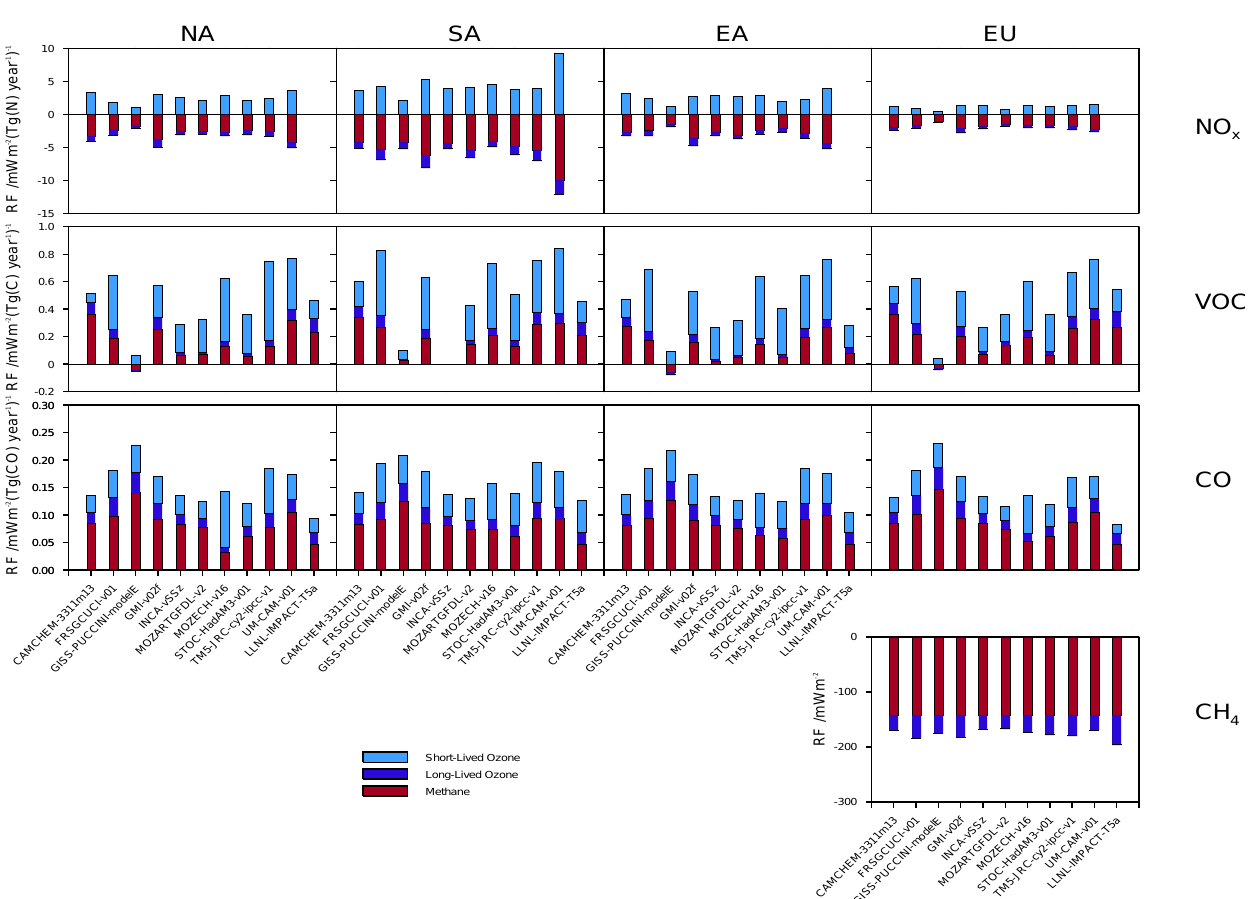
Figure 3. Radiative forcing, normalised by emissions mass change, for NO x (first row), VOCs (second row), CO (third row), and CH 4 (bottom), for each of the 11 models, for each of the four regions given in Table 1. Units are mWm − 2 ( Tgyear − 1 ) − 1 for the NO x , VOCs and CO cases. For the CH 4 case, results are presented un-normalised, in mWm − 2 . Colours show RF due to short-lived ozone (light blue), methane (red) and long-lived ozone (dark